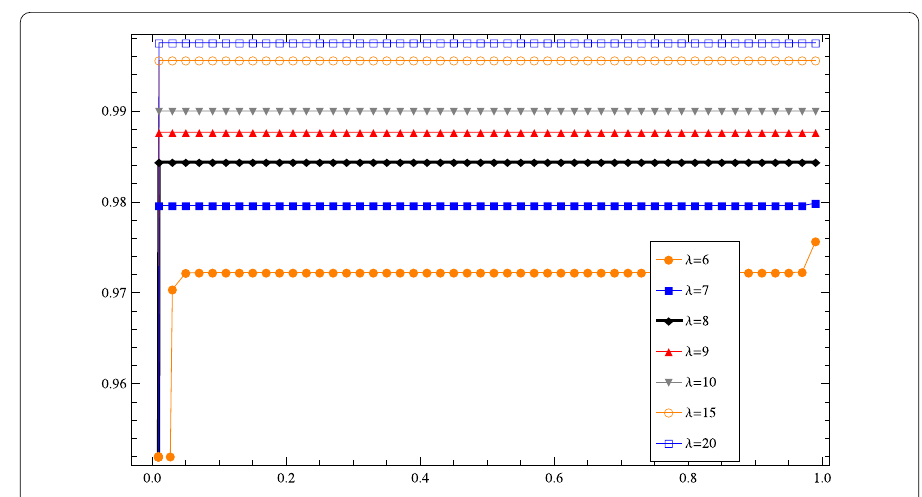
Figure 13 Plot of numerical solutions of approach I for ν 0 = 1, λ = 6,7,8,9,20, and n = 1